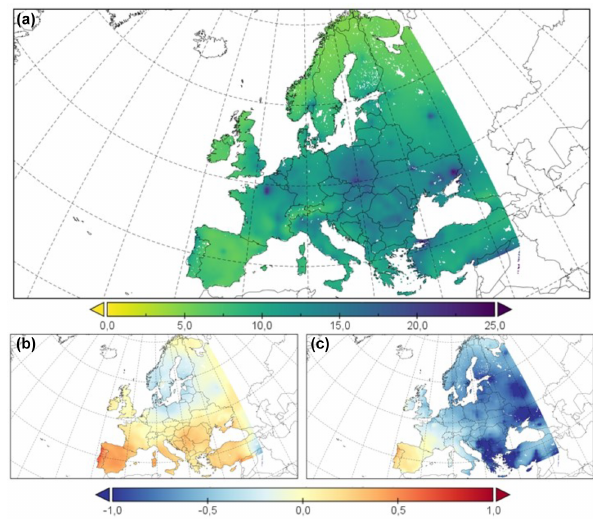
Figure 5. PM 2 . 5 concentrations over Europe: (a) in the present scenario (1991–2010); (b) difference between the future scenario (2031–2050, RCP8.5) and the present scenario; (c) difference be- tween the future (2031–2050, RCP8.5) + 80% renewable ener- gies scenario (REN80) and the present scenario. All values are in µgm − 3 .